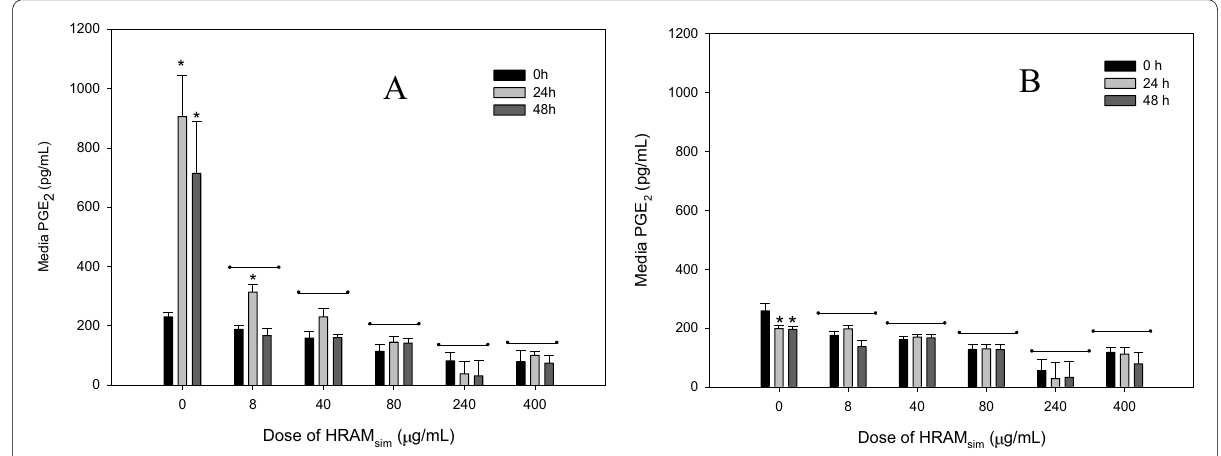
Figure 2 Figure - Prostaglandin E 2 [PGE 2 ] production by cartilage explants stimulated with LPS [3 or 0 μg/mL; Panels A and B, respectively] . Explants were conditioned with HRAM sim [0, 8, 40, 80, 240 or 400 μg/mL] for 96 h, and were stimulated with LPS for the final 48 h. Data shown are for the final 48 hours only. * represents significant effect of LPS; -- represents treatments significantly different from controls. There was no significant effect of any dose of CM , , RA or any RA There was no significant effect of CM sim sim RA or any RA metabolite on PGE metabolites on NO production by LPS-stimulated or production in LPS- 2 unstimulated explants (Additional file 1). stimulated or unstimulated explants (Additional file 1).